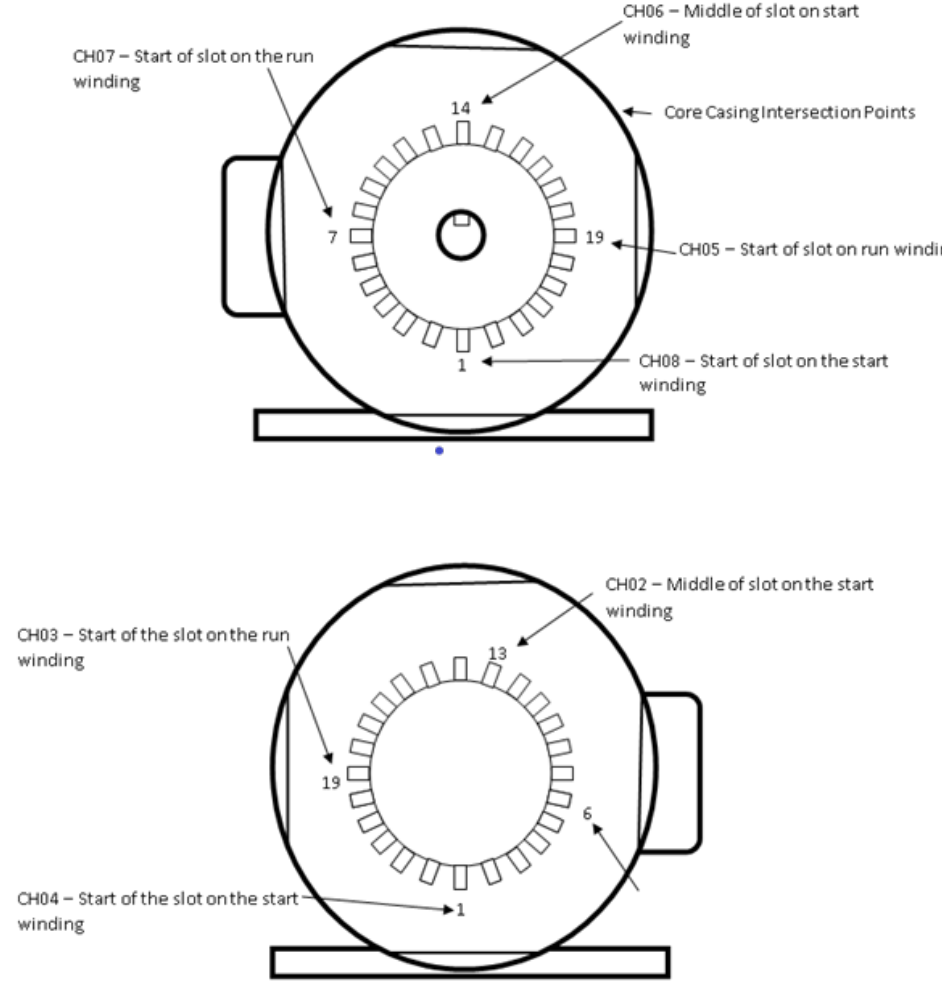
Figure 6. Schematic showing the placement of the thermocouples on the motor being tested. ( Top ): Front view. ( Bottom ): Back